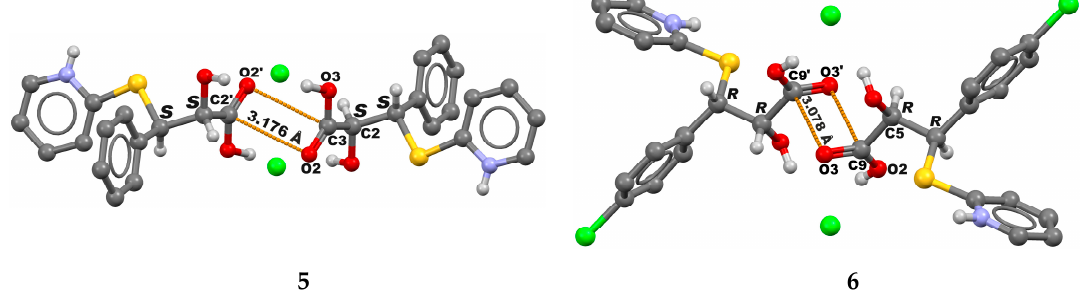
Figure 3. Tetrel bonds in 5 and 6 (shown as dashed orange lines).